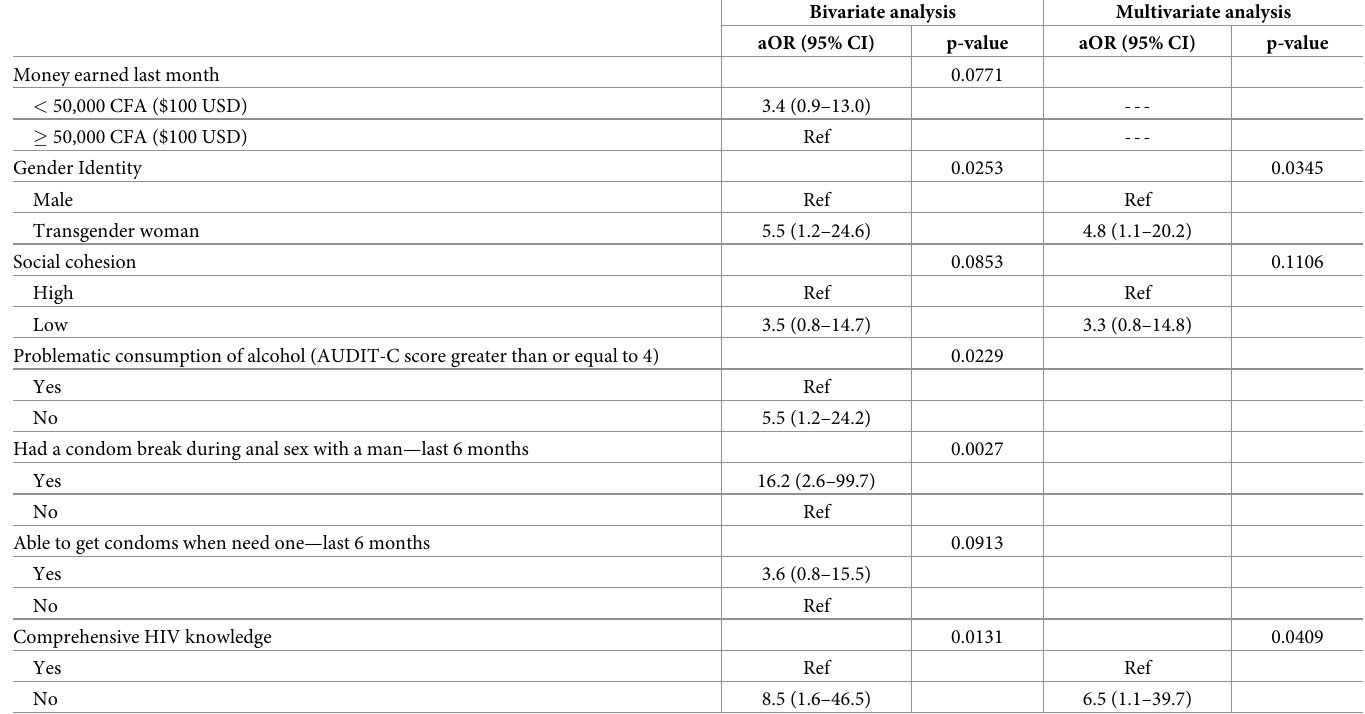
Table 4. Factors associated with not having suppressed viral load among MSM and TGW in Bamako, Mali